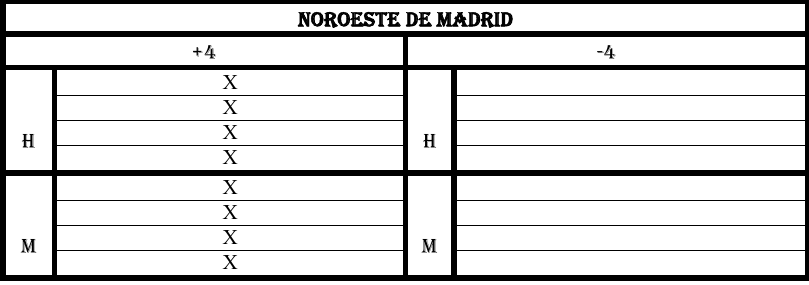
Figure 5. Data on the informants surveyed in the northwest area of Madrid.